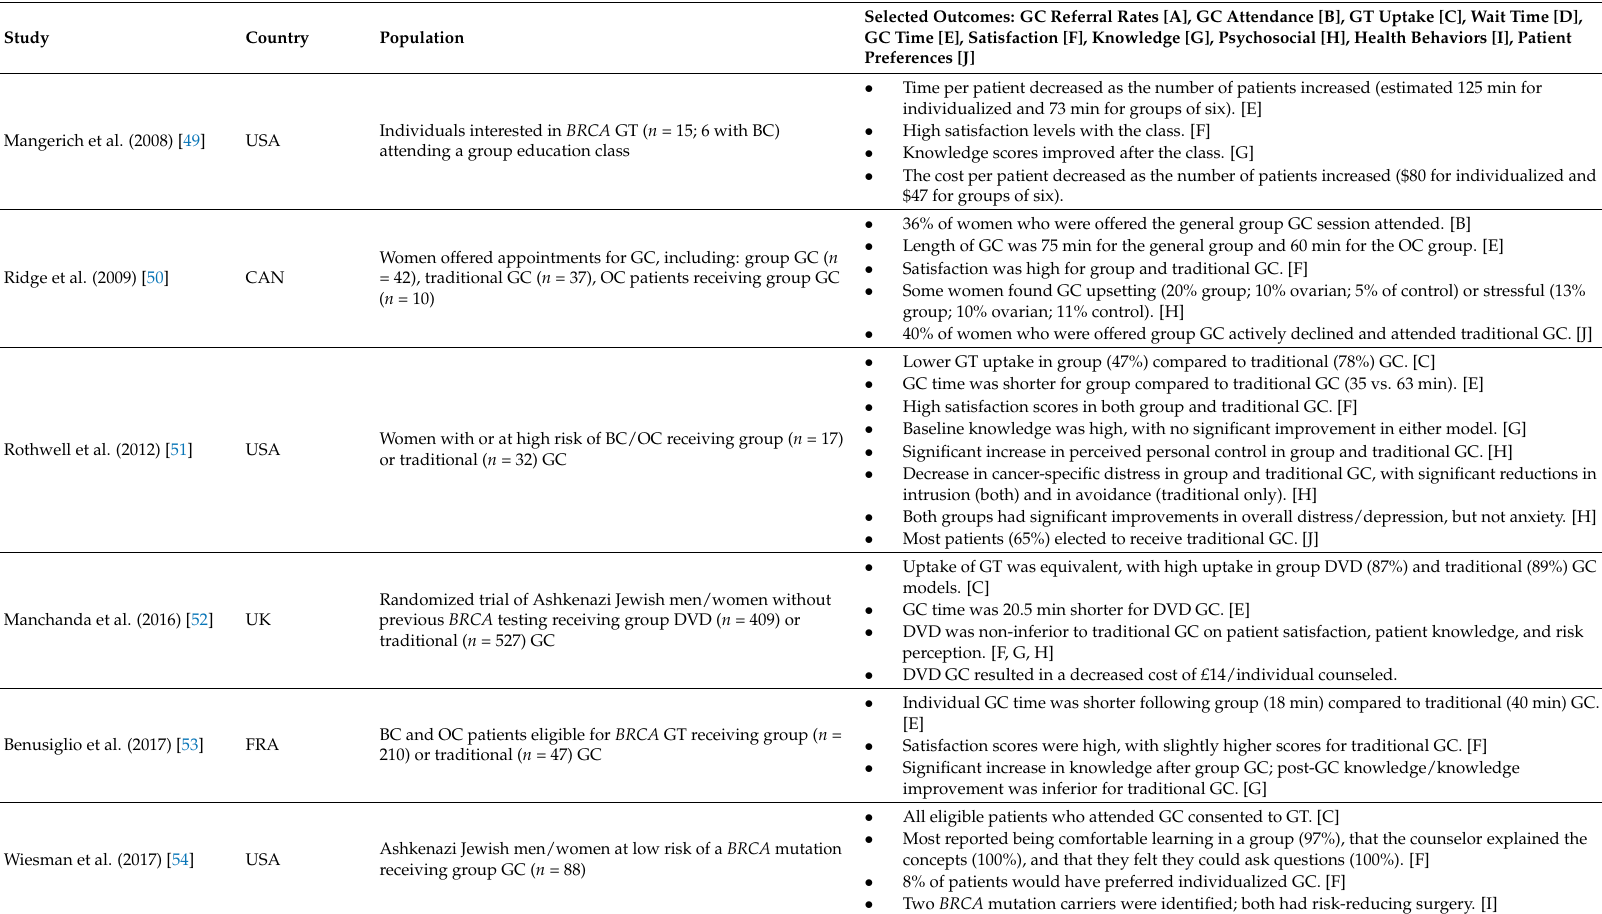
Table 3. Group genetic counseling